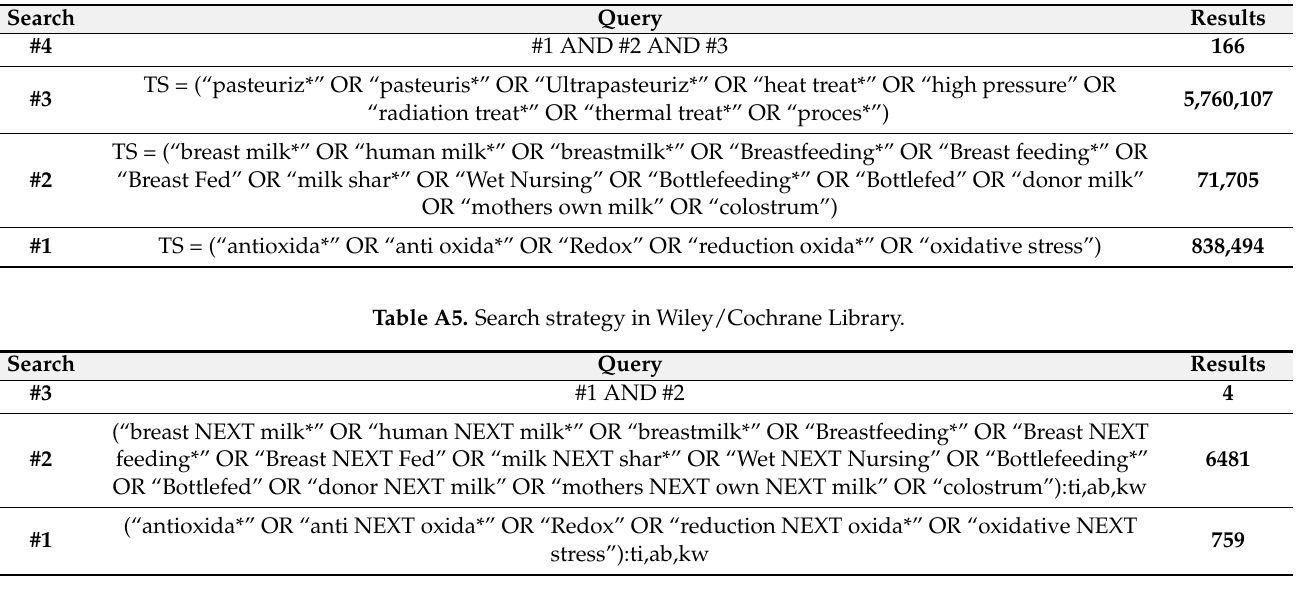
Table A4. Search strategy in Clarivate Analytics/Web of Science Core Collection.